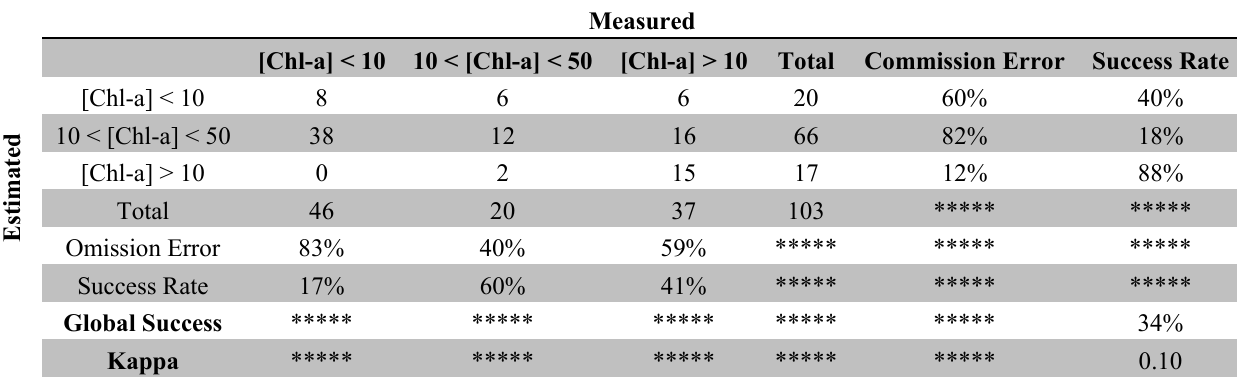
Table 8. The Kahru confusion matrix